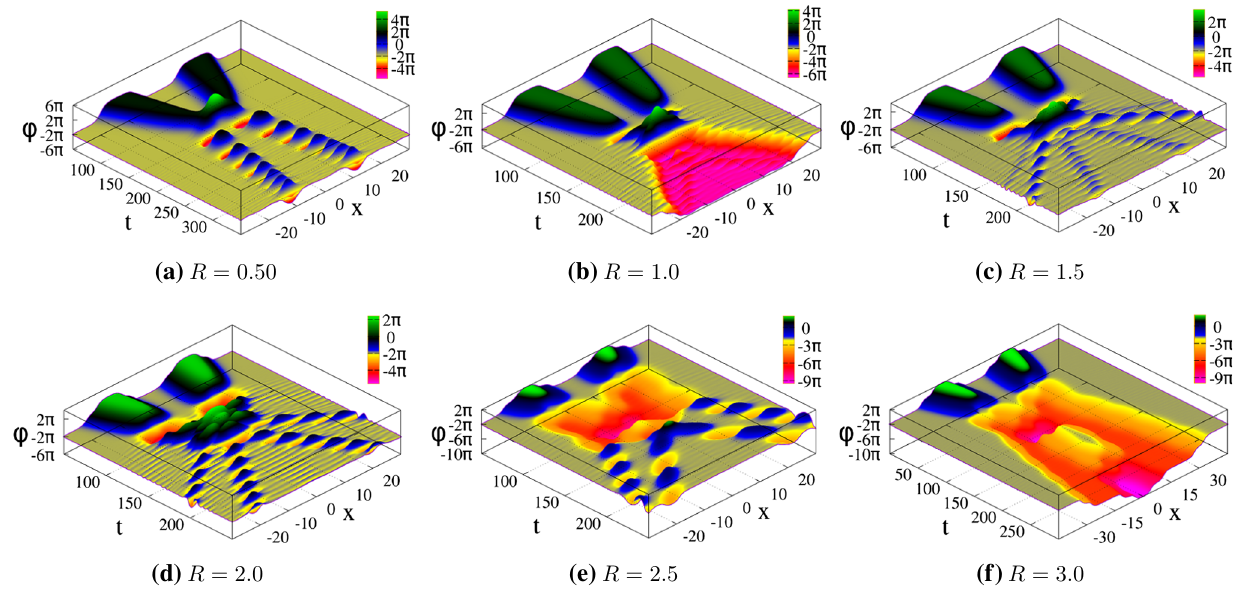
Fig. 12 Space-time picture of collisions of four kinks for different R